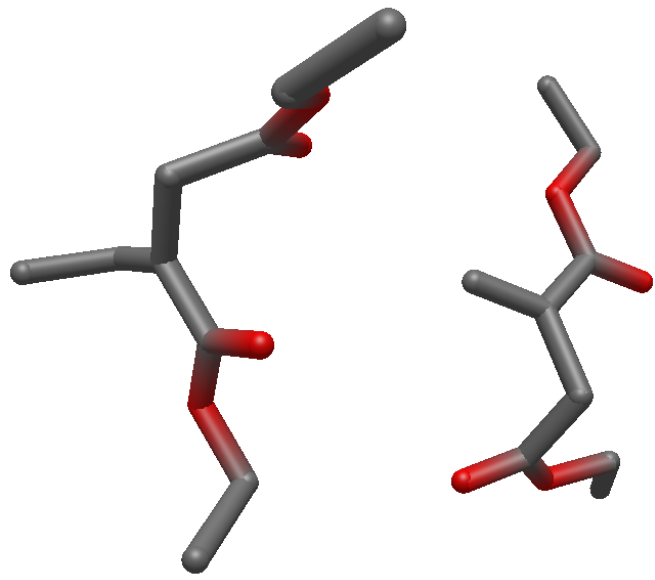
Figure A2. Structure of the transition state on UHF/6 ‐ 31G(d) level of theory.